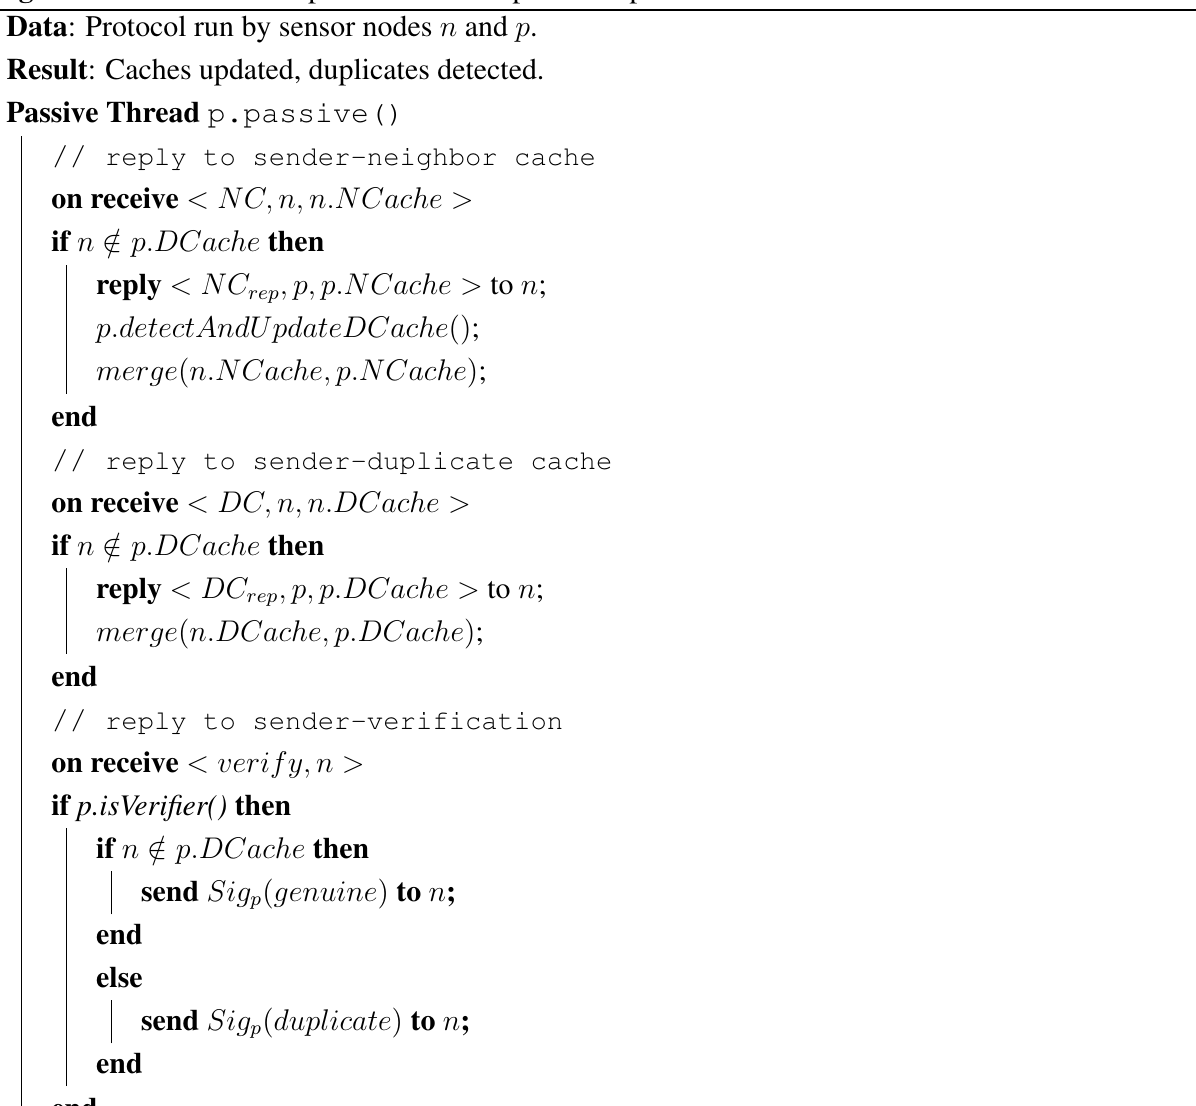
Algorithm 2: Discard duplicate detection protocol: passive thread. Data : Protocol run by sensor nodes n and p